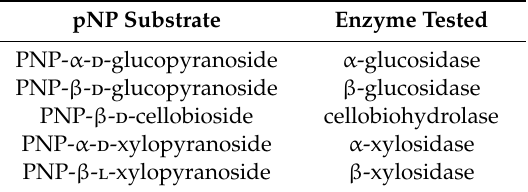
Table 1. p-nitrophenyl (pNP) substrates prepared and enzymatic reaction